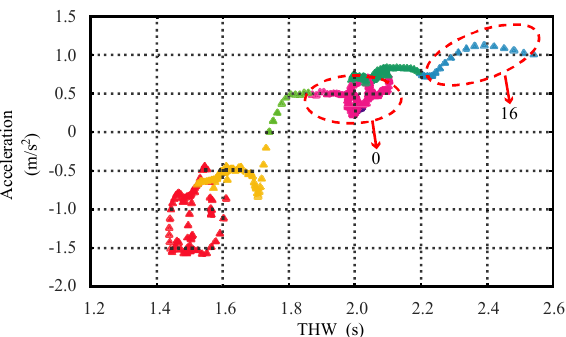
Figure 12. The scatter map of driver #5 in one following event.